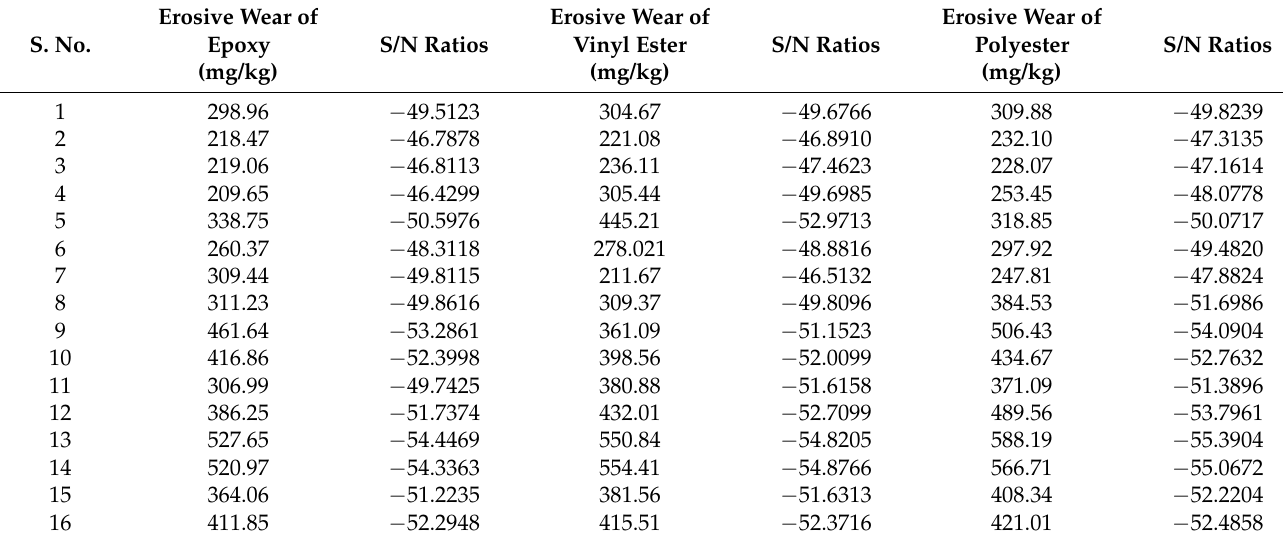
Table 6. Erosive wear and corresponding S/N ratio of the